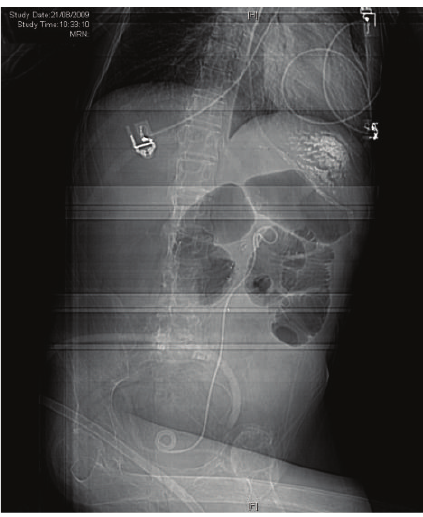
Figure 6: Scout film of abdomen, taken on 21 August 2009, showed dilated proximal small bowel loops.